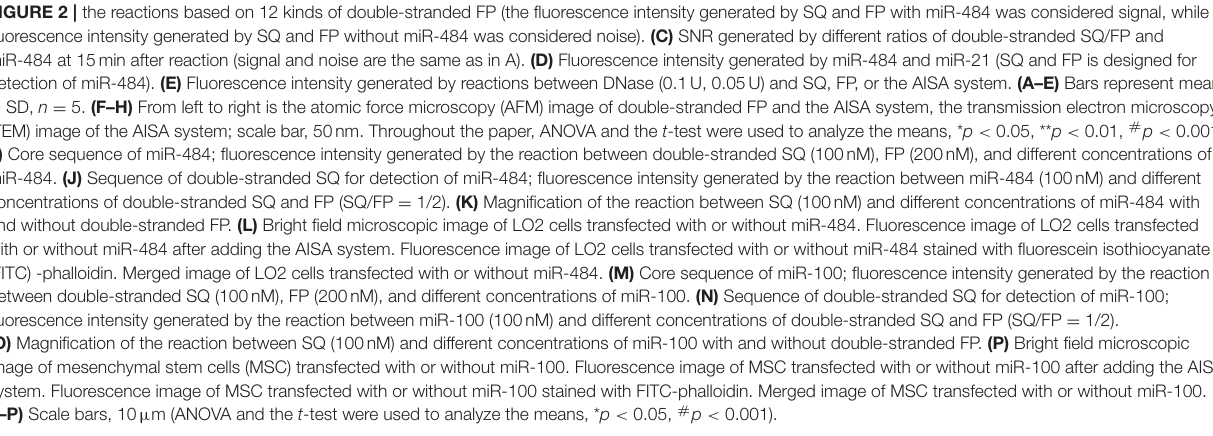
FIGURE 2 | the reactions based on 12 kinds of double-stranded FP (the fluorescence intensity generated by SQ and FP with miR-484 was considered signal, while fluorescence intensity generated by SQ and FP without miR-484 was considered noise). (C) SNR generated by different ratios of double-stranded SQ/FP and miR-484 at 15min after reaction (signal and noise are the same as in A). (D) Fluorescence intensity generated by miR-484 and miR-21 (SQ and FP is designed for detection of miR-484). (E) Fluorescence intensity generated by reactions between DNase (0.1U, 0.05U) and SQ, FP, or the AISA system. (A–E) Bars represent mean ± SD, n = 5. (F–H) From left to right is the atomic force microscopy (AFM) image of double-stranded FP and the AISA system, the transmission electron microscopy (TEM) image of the AISA system; scale bar, 50nm. Throughout the paper, ANOVA and the t -test were used to analyze the means, * p < 0.05, ** p < 0.01, # p < 0.001. (I) Core sequence of miR-484; fluorescence intensity generated by the reaction between double-stranded SQ (100nM), FP (200nM), and different concentrations of miR-484. (J) Sequence of double-stranded SQ for detection of miR-484; fluorescence intensity generated by the reaction between miR-484 (100nM) and different concentrations of double-stranded SQ and FP (SQ/FP = 1/2). (K) Magnification of the reaction between SQ (100nM) and different concentrations of miR-484 with and without double-stranded FP. (L) Bright field microscopic image of LO2 cells transfected with or without miR-484. Fluorescence image of LO2 cells transfected with or without miR-484 after adding the AISA system. Fluorescence image of LO2 cells transfected with or without miR-484 stained with fluorescein isothiocyanate (FITC) -phalloidin. Merged image of LO2 cells transfected with or without miR-484. (M) Core sequence of miR-100; fluorescence intensity generated by the reaction between double-stranded SQ (100nM), FP (200nM), and different concentrations of miR-100. (N) Sequence of double-stranded SQ for detection of miR-100; fluorescence intensity generated by the reaction between miR-100 (100nM) and different concentrations of double-stranded SQ and FP (SQ/FP = 1/2). (O) Magnification of the reaction between SQ (100nM) and different concentrations of miR-100 with and without double-stranded FP. (P) Bright field microscopic image of mesenchymal stem cells (MSC) transfected with or without miR-100. Fluorescence image of MSC transfected with or without miR-100 after adding the AISA system. Fluorescence image of MSC transfected with or without miR-100 stained with FITC-phalloidin. Merged image of MSC transfected with or without miR-100. (I–P) Scale bars, 10 µ m (ANOVA and the t -test were used to analyze the means, * p < 0.05, # p <